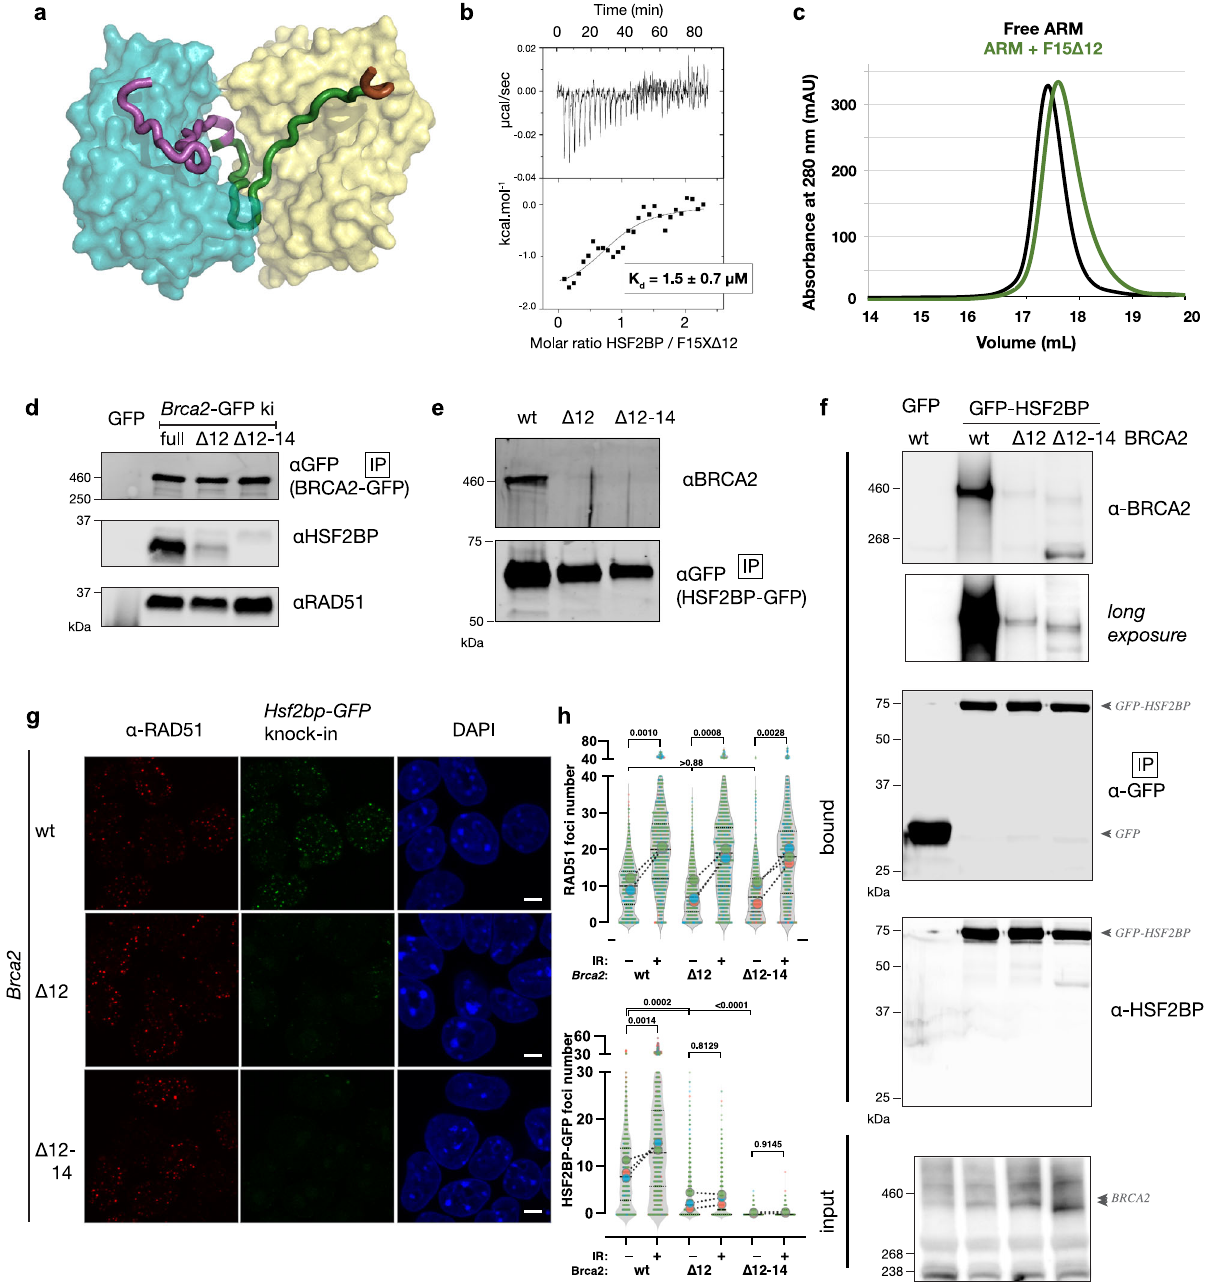
Fig. 5 Deletion of Brca2 exon 12 disrupts HSF2BP-BRCA2 interaction in cells. a Structure of the HSF2BP dimer interacting with the BRCA2 peptide colored by encoding exon number. b ITC experiment with HSF2BP and a truncated variant of F15X peptide missing residues encoded by exon 12 (F15X Δ 12). c ARM and the complex between ARM and F15X Δ 12 analyzed by analytical gel fi ltration (column: Superose 6 Increase 10/300 GL). d Immunoblot analysis of proteins co-precipitated with anti-GFP nanobody beads from mES cells containing homozygous Brca2-GFP allele without (full) or with deletions of exon 12 or exons 12 – 14. The experiment was performed four times with similar results. e Immunoblot analysis of proteins co-precipitated with anti-GFP nanobody beads from double knock-in mES cells containing homozygous Hsf2bp-GFP and Brca2 alleles without or with deletion of exons 12 or 12 – 14. The experiment was performed two times with similar results. f Immunoblot analysis of proteins co-precipitated with anti-GFP nanobody beads from HeLa cells stably overproducing GFP-HSF2BP or GFP control, and in which BRCA2 allele was modi fi ed by excision of exons 12 or exons 12 – 14, or unmodi fi ed wild-type (wt) BRCA2 . g Hsf2bp GFP/GFP Brca2 wt/wt , Hsf2bp GFP/GFP Brca2 Δ 12/ Δ 12 , and Hsf2bp GFP/GFP Brca2 Δ 12-14/ Δ 12-14 mES cells were irradiated with 8 Gy, fi xed after 2 h recovery, immunostained with anti-RAD51 antibody, mounted with DAPI, and imaged using laser confocal microscope. HSF2BP-GFP was detected by direct fl uorescence. Maximum projection of three confocal slices (0.5 µ m apart) is shown. Scale bar = 5 µ m. h Quanti fi cation of HSF2BP-GFP and RAD51 foci from the experiments as the one shown in g . Data from three independent experiments are plotted following the SuperPlots approach 66 : symbol colors indicate biological replicas ( n = 3), small symbols show number of foci per nucleus, violin plot shows the combined frequency distribution, with lines indicating median and quartiles; large circles indicate means within replicas, dotted lines visualize changes after irradiation. Replica means were compared by one-way ANOVA with Tukey multiple comparison test, p -values are